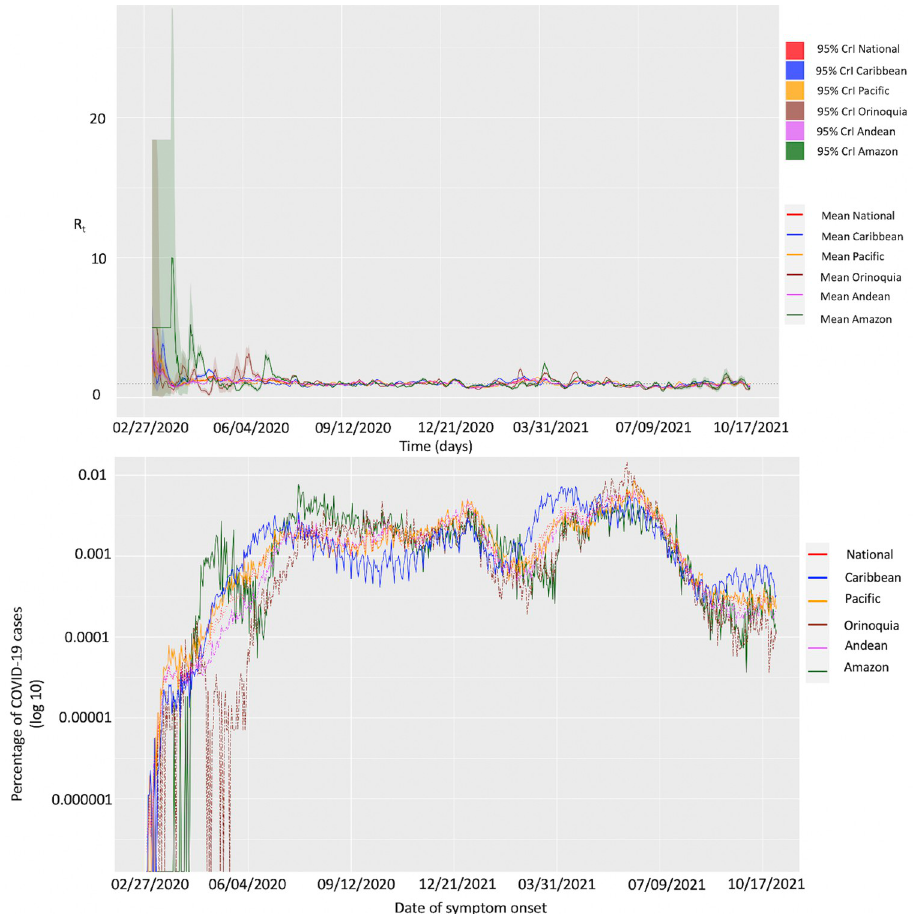
Fig 8. Upper panel: Effective reproduction number estimated from the Cori et al. method with 95% credible intervals for the COVID-19 pandemic in Colombia as of October 31, 2021. The red solid line represents the mean reproduction number for Colombia and the red shaded area represents the 95% credible interval around it. The blue solid line represents the mean reproduction number in the Caribbean region and the blue shaded area represents the 95% credible interval around it. The yellow solid line represents the mean reproduction number in the Pacific region and the yellow shaded area represents the 95% credible interval around it. The brown solid line represents the mean reproduction number in the Orinoquı´a region and the brown shaded area represents the 95% credible interval around it. The pink solid line represents the mean reproduction number in the Andean region and the pink shaded area represents the 95% credible interval around it. The green solid line represents the mean reproduction number in the Amazon and the green shaded area represents the 95% credible interval around it. Lower panel: The percentage of the COVID-19 cases in Colombia, nationally and regionally as of October 31, 2021. The red solid line represents the percentage of cases in Colombia, the blue solid line represents the percentage of cases in the Caribbean region, the yellow solid line represents the percentage of cases in the Pacific region, the brown dotted line represents the percentage of cases in the Orinoquı´a region, the pink dashed line represents the percentage of cases in the Andean region and the green dotted line represents the percentage of cases in the Amazon